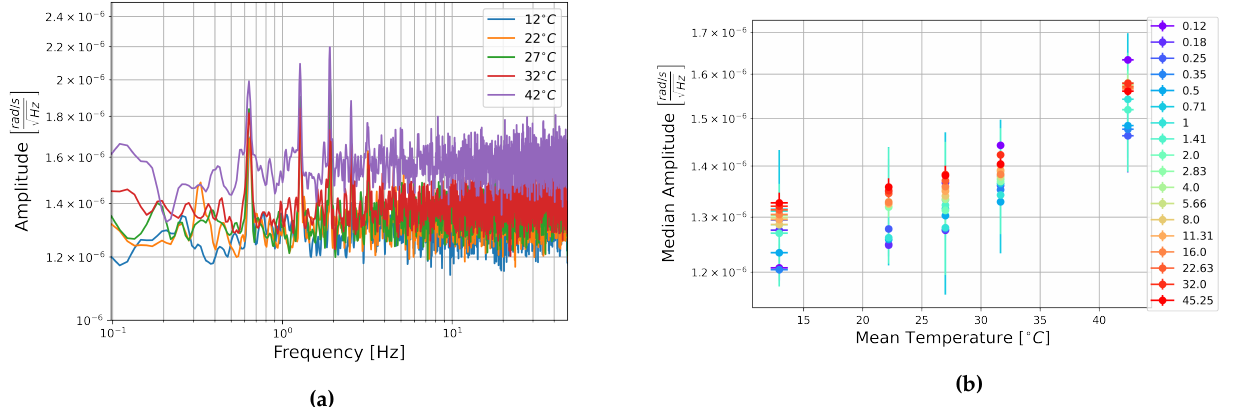
Figure 10. ( a ) Square root of the PSD of component HJX at each temperature step and ( b ) Median amplitude of the PSD per half-octave as a function of temperature. Vertical error bars show STD of amplitudes, and horizontal bars show STD of temperature